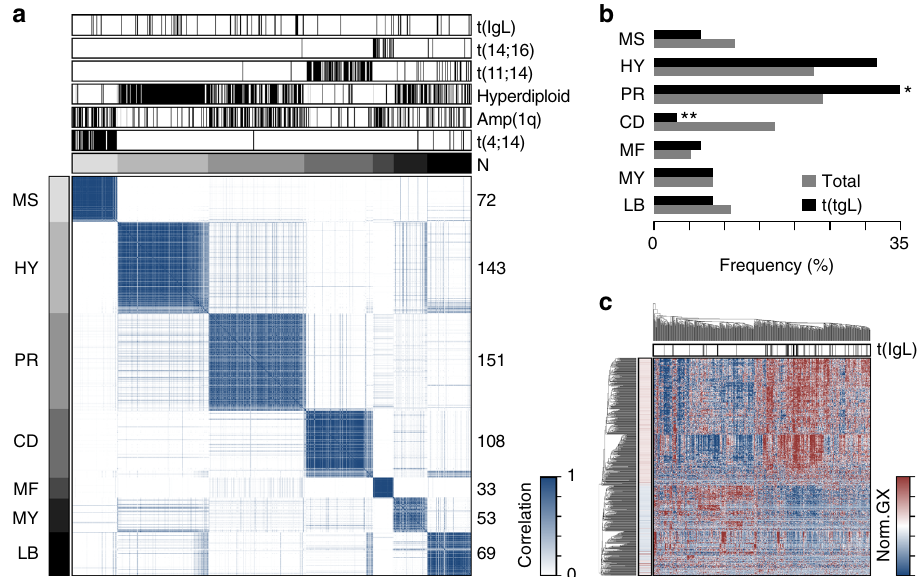
Fig. 5 IgL translocations occur in all gene expression subtypes. a Consensus clustering of 629 newly diagnosed myelomas with whole genome sequencing and RNA-seq. Expression subtypes are denoted by gray annotation bars (top and left), and labels correspond with those de fi ned by Zhan et al. 24 . The number of samples are denoted on the right. b Frequency of gene expression subtypes in all myelomas (gray) and in t(IgL) myeloma (black). c Heatmap of genes differentially expressed in t(IgL) myeloma as compared to others. Samples (columns) are clustered with t(IgL) status annotated (top; black) and gene signi fi cance denoted (left). * P < 0.05; ** P < 0.01, two-sided Fisher ’ s exact test. Source data are provided as a Source Data fi